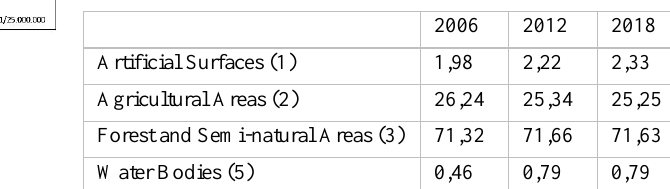
Figure 1. Location map of Alanya